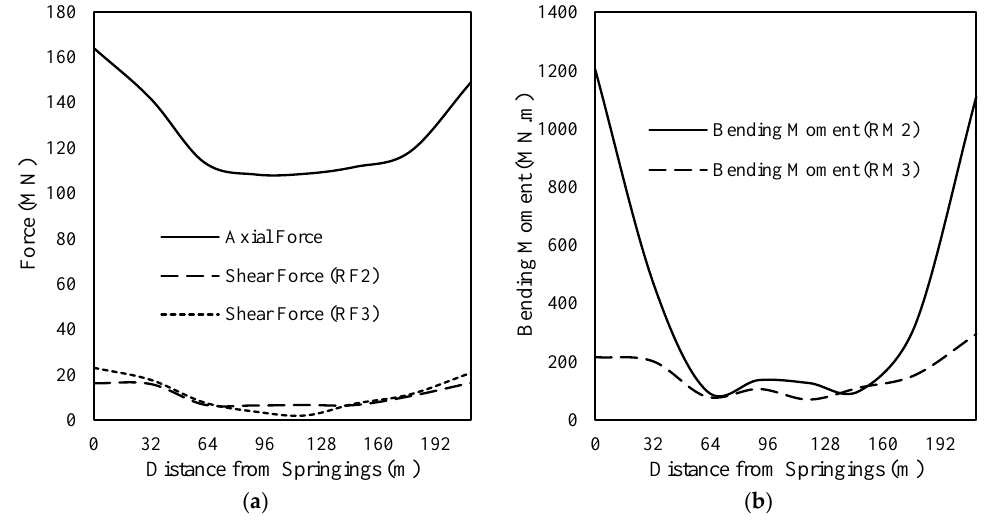
Figure 12. Distribution of the average internal forces in the RC arch due to near-field earthquakes. ( a ) Axial and shear forces; ( b ) Bending moments.